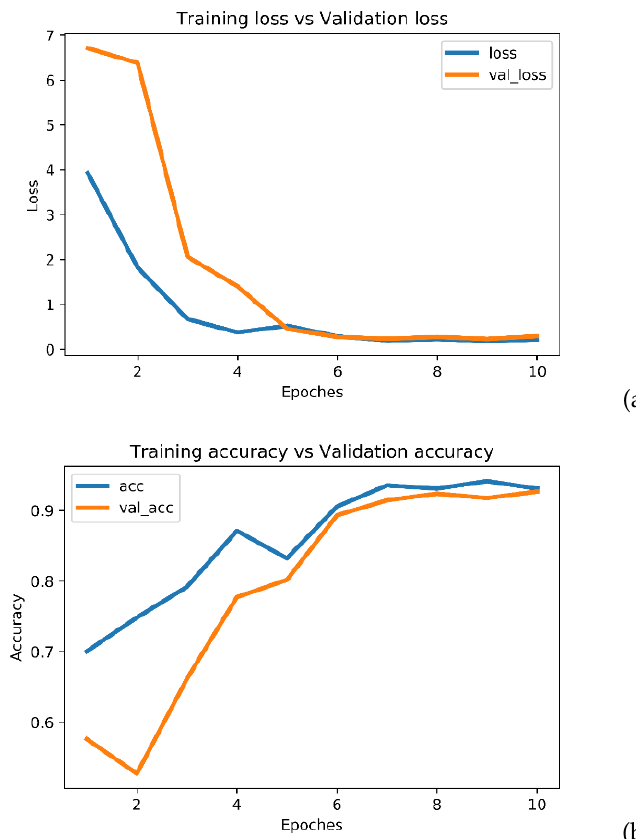
Figure 13. Accuracy and loss graphs for ResNet50 for Blade/Non-Blade classification ( image size = 32 32, database size = 1000, epoch = 10). ( a ) The loss ( b ) The accuracy. × Table 4. Comparison of four pertained classification approaches for Blade and Non-Blade binary classification